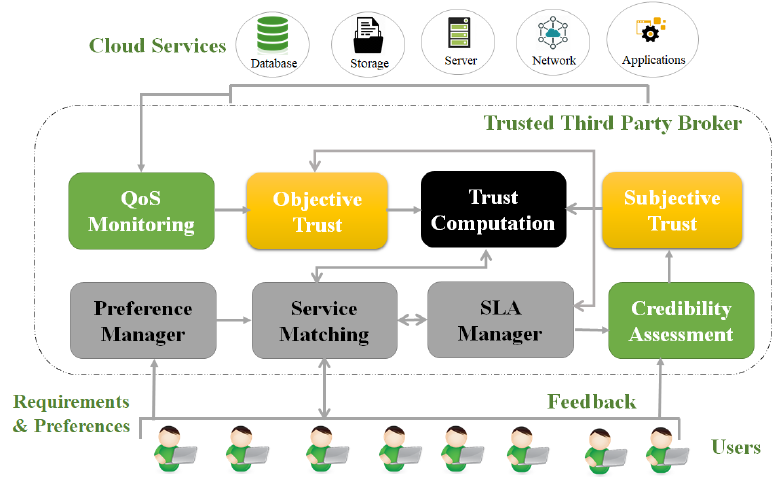
Figure 1. Proposed Trust Computation